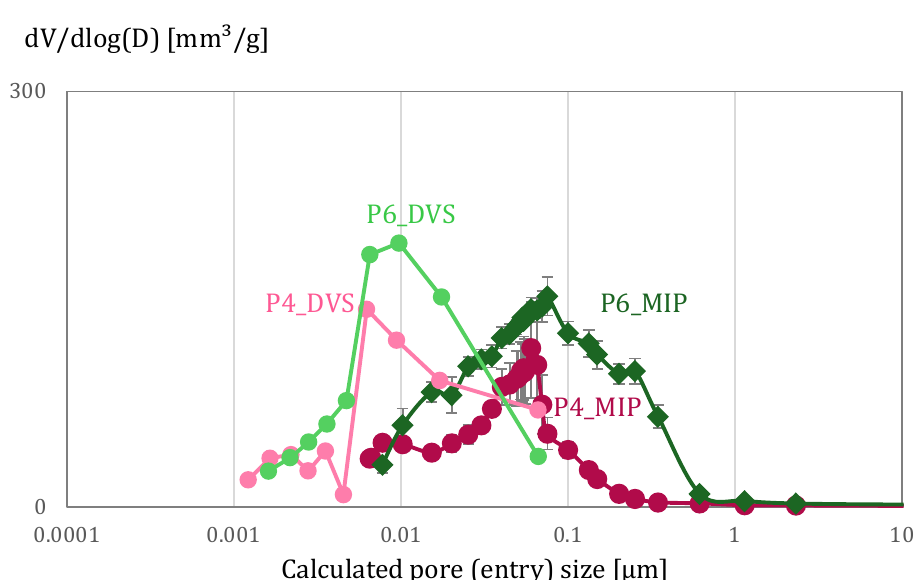
Figure 5. Porosity values obtained from MIP, DVS, WA and PB of pastes P4 and P6.